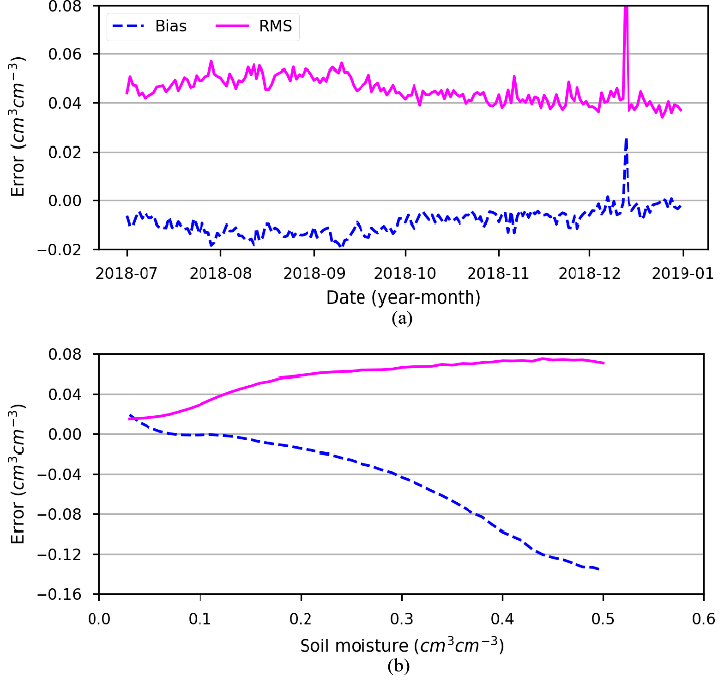
Figure 9. Testing data daily error statistic ( a ) and total retrieval error at different soil moisture bins ( b ).